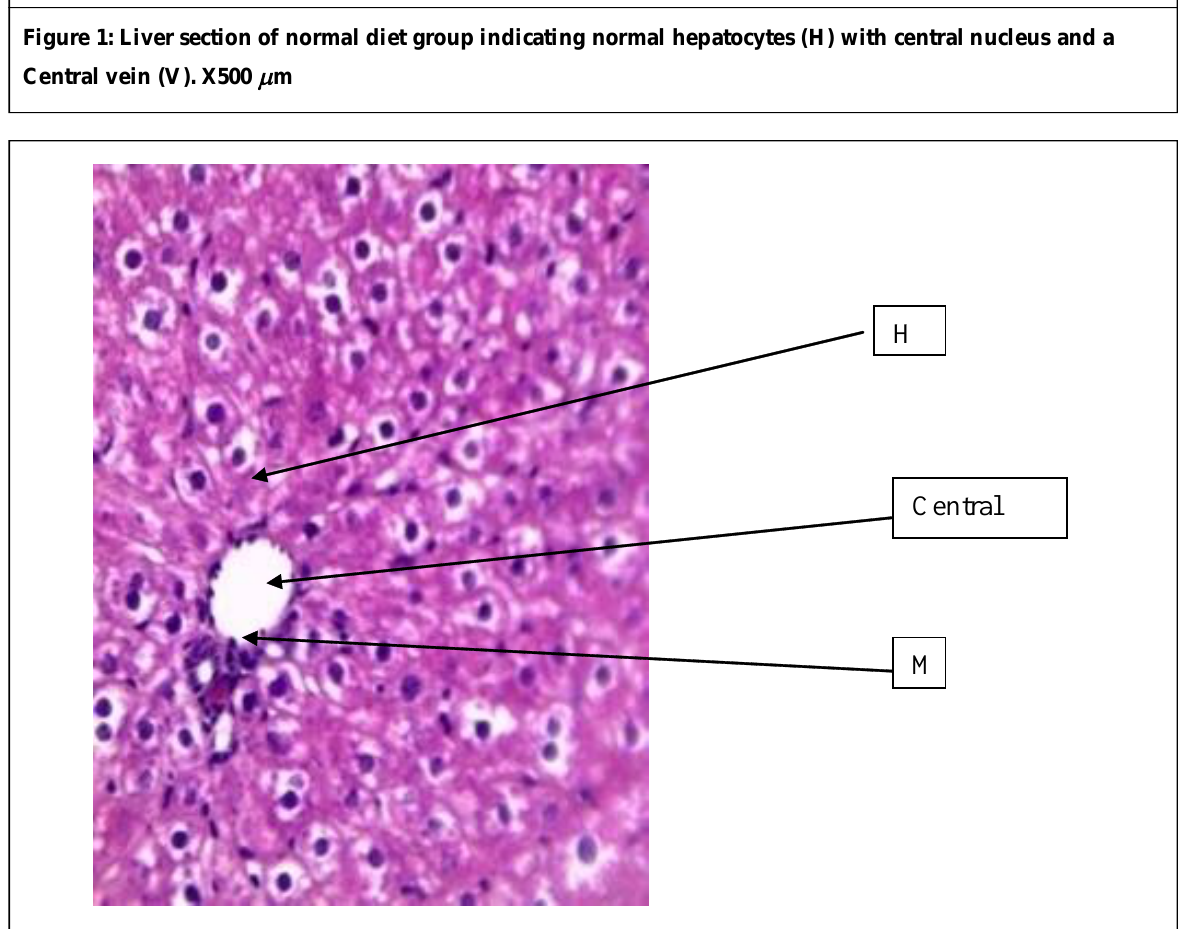
Figure 2: Liver section from RHFD group; portal cell inflamation (M) and mixed steatosis and mild hepatocellular ballooning (HP), X500 